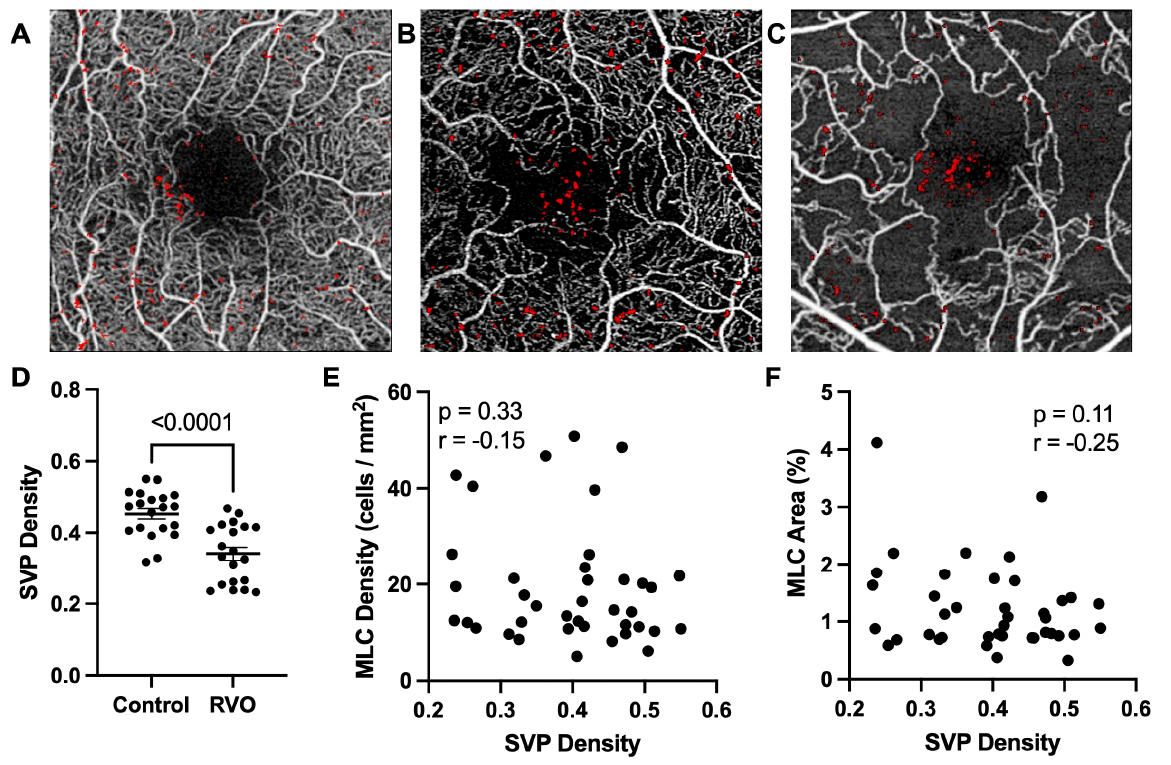
Figure 2. MLCs do not correlate with SVP. Representative examples of high ( A ), medium ( B ) and low ( C ) SVP density eye with MLCs marked in red. ( D ) Perifoveal SVP density was significant reduced in RVO eyes. MLC density ( E ) and MLC percent area ( F ) were not correlated with SVP density.